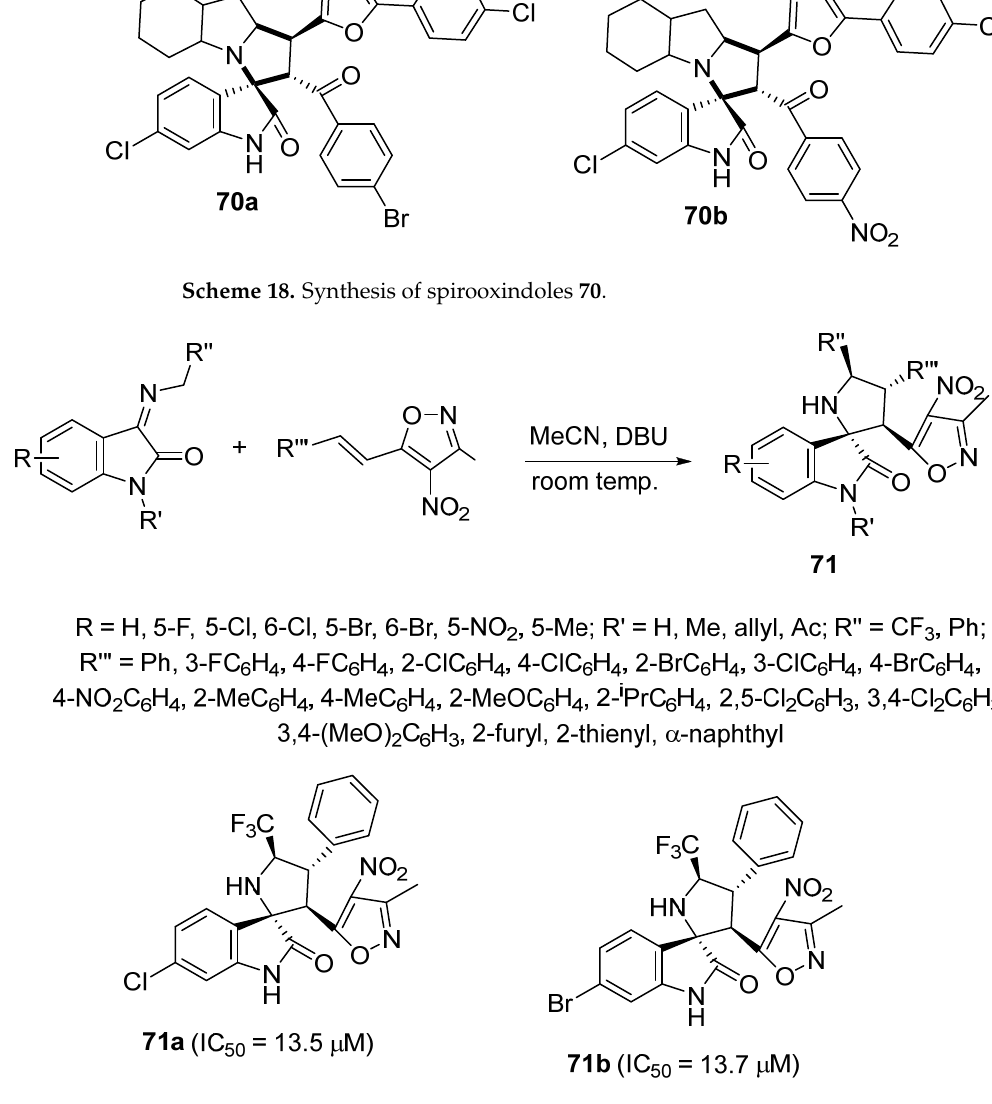
Scheme 18. Synthesis of spirooxindoles 70